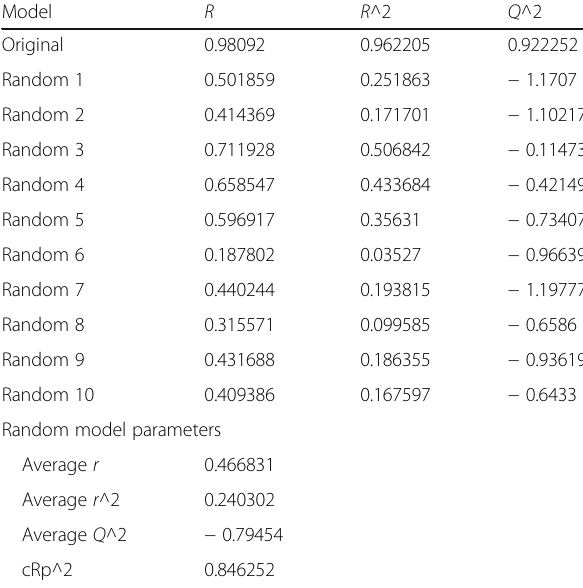
Table 6 Y -randomization test